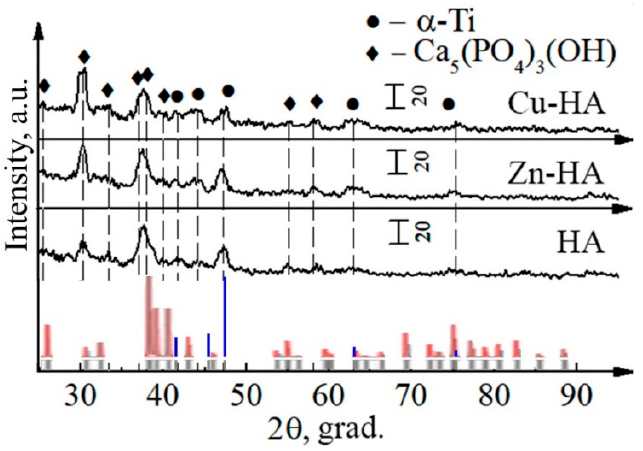
Figure 18. XRD of the CaP coatings after post-deposition annealing in air (red, blue, and gray lines represent HA (red) and Ti (blue) etalon XRD patterns according to PDF-card no. 00-009-0432 and 00-044-1294, respectively).